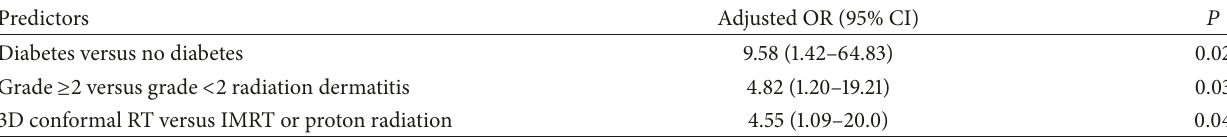
Table 4: Multivariable analysis of predictors for any wound